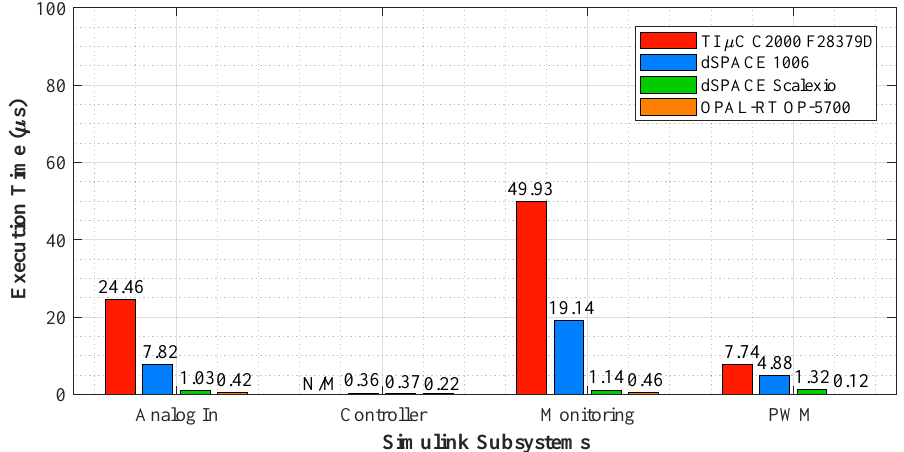
Figure 16. Time Profiling for LQI ( dq ) controller, full.